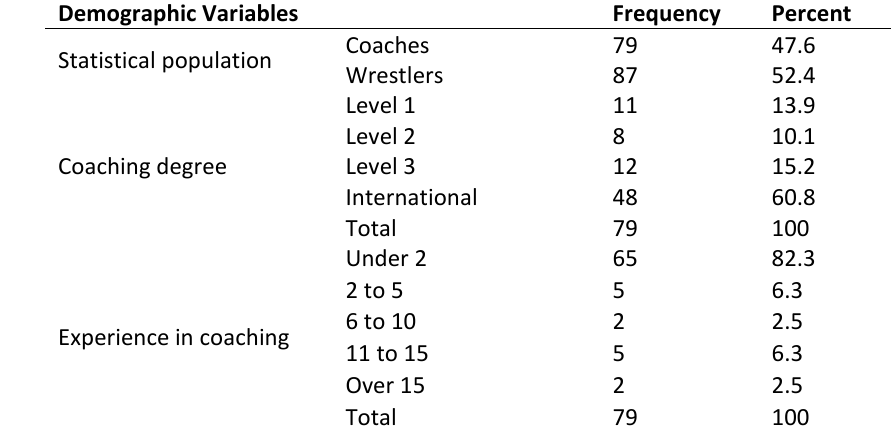
Table 1. Distribution and frequency rate of demographic